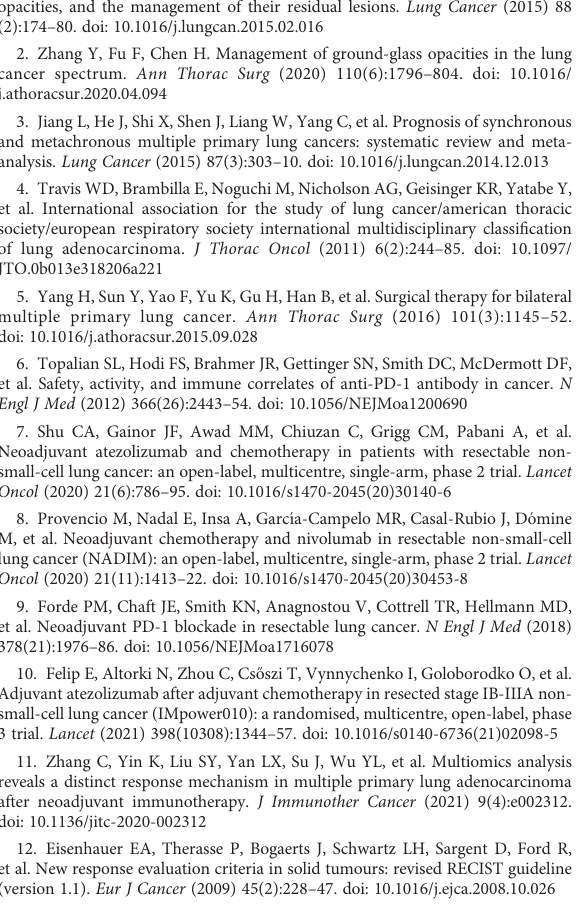
SUPPLEMENTARY TABLE 5 The results of DMR detection by performing